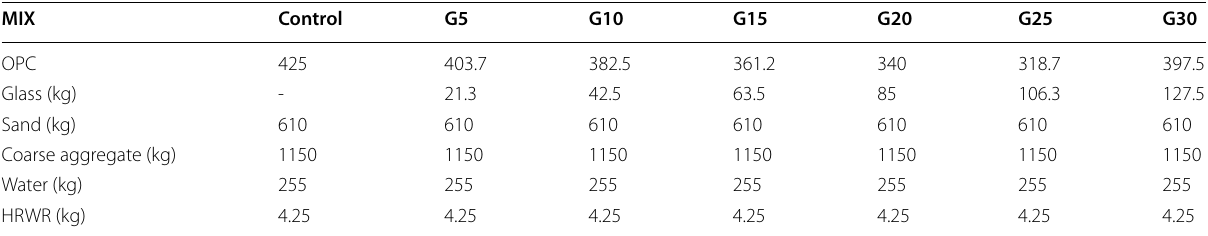
Table 4 Concrete mix proportion per m 3 .